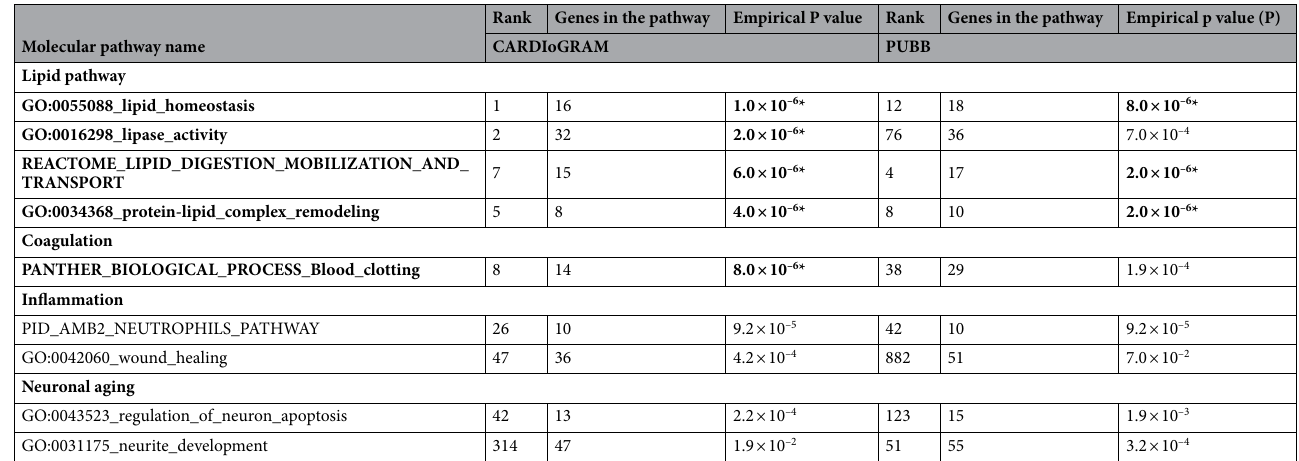
Table 4. Top one percent VEGAS2 lipid and non-lipid based enriched pathways in CARDIoGRAM (CGEX) and Pan UK Biobank (PUBB). GO gene ontology, PID pathway interaction database, PUBB Pan UK Biobank. Empirical p value: Obtained from resampling genes from the pathway and calculated as the number of instances the summed chi-squared test statistics per resample exceeds observed test statistic. *Pathways in bold with empirical pathway significance threshold was defined was p ≤ 10 –5